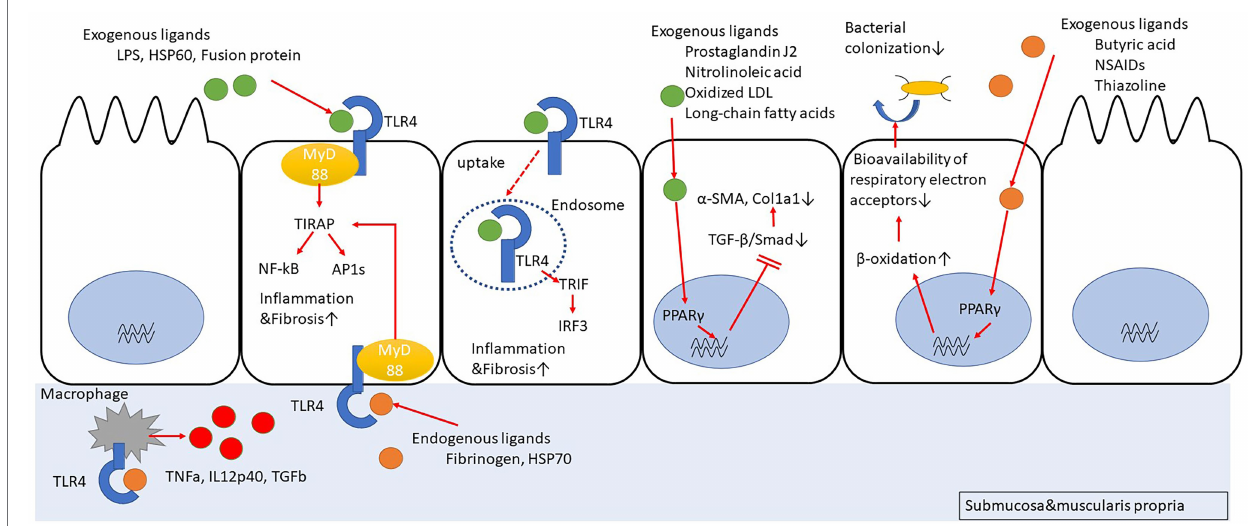
FIGURE 1 | Peroxisome proliferator-activating receptor gamma (PPAR γ ) suppresses fibrosis by inhibiting Smad. PPAR γ promotes cellular β -oxidation and inhibits bacterial colonization in intestinal epithelial cells. Toll-like receptor 4 (TLR4) stimulation induces inflammation/fibrosis. Macrophages activated with TLR4 stimulation produce pro-inflammatory